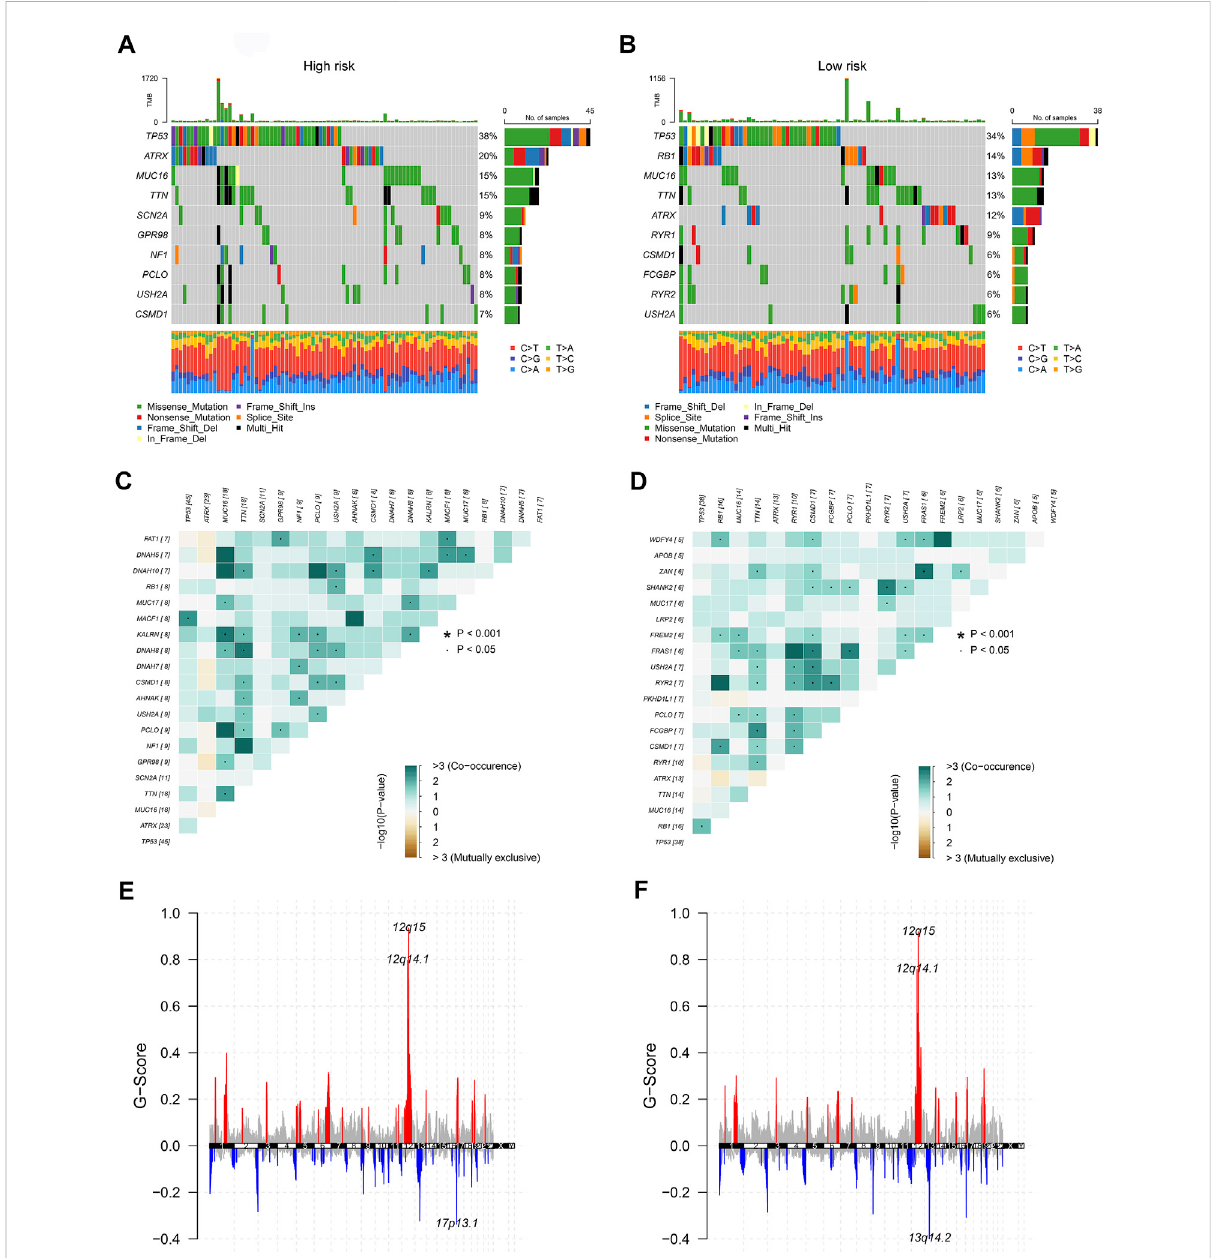
FIGURE 3 The genetic characteristics of the CuLncScore grouping. Somatic mutation characteristics of the high (A) and low (B) risk groups. The co- occurrence and mutually exclusive mutations of thedifferently mutatedgenes in thehigh (C) and low (D) risk groups. GISTIC 2.0 ampli fi cations (red) and deletions (blue) in the high (E) and low (F) CuLncScore